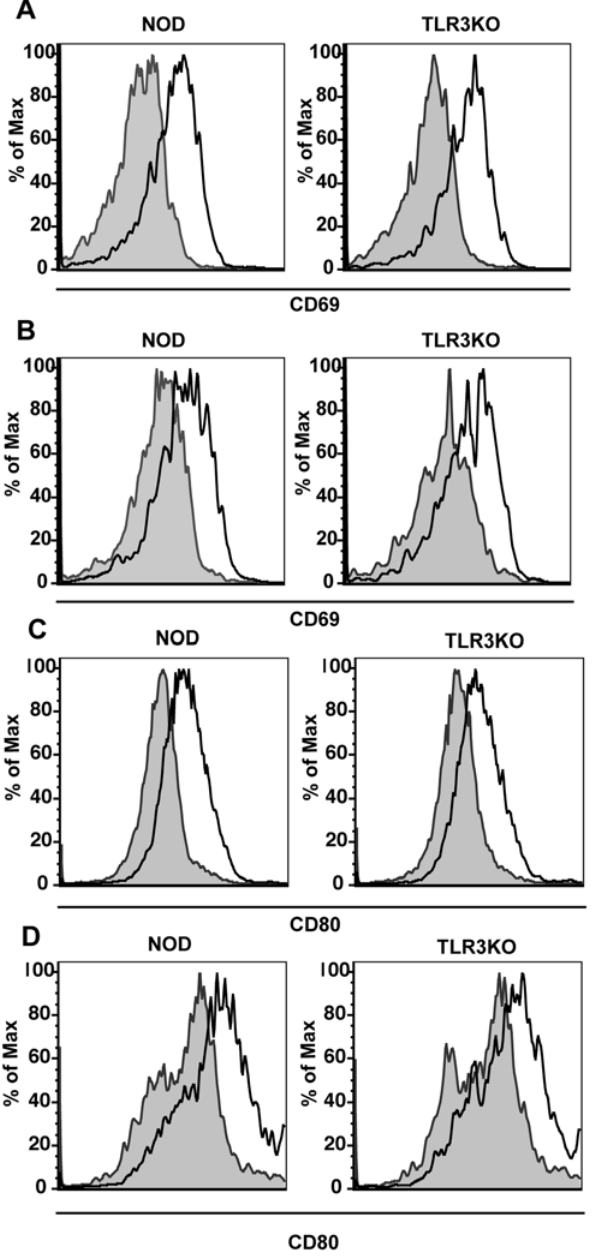
Figure 4. TLR3 deficiency does not affect the capacity of T cells to activate following CB4 infection. Representative histograms of CD62L and CD69 expression on the surface of (A) CD4 and (B) CD8 T cells from WT NOD (left panels) and TLR3KO (right panels) mice at 4 days post-infection with 400 pfu of CB4 (solid black lines) or mock- infection with DMEM (shaded histogram). Data is representative of at least 2 separate experiments.